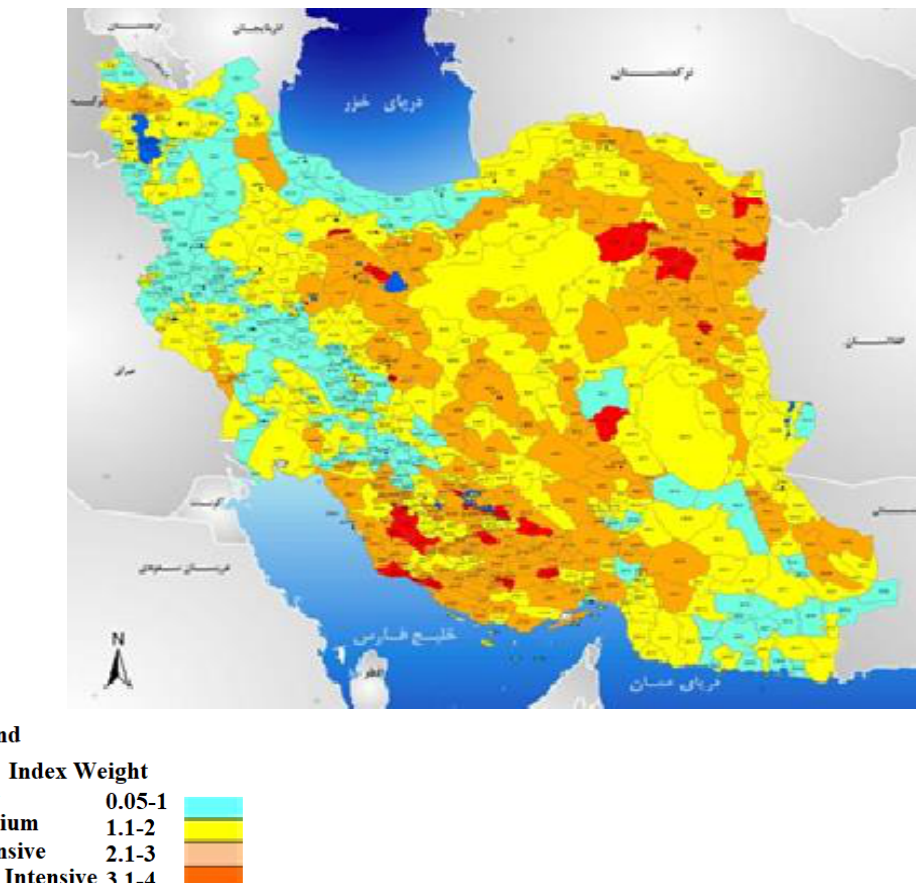
Figure 3. zoning of the country based on water and irrigation